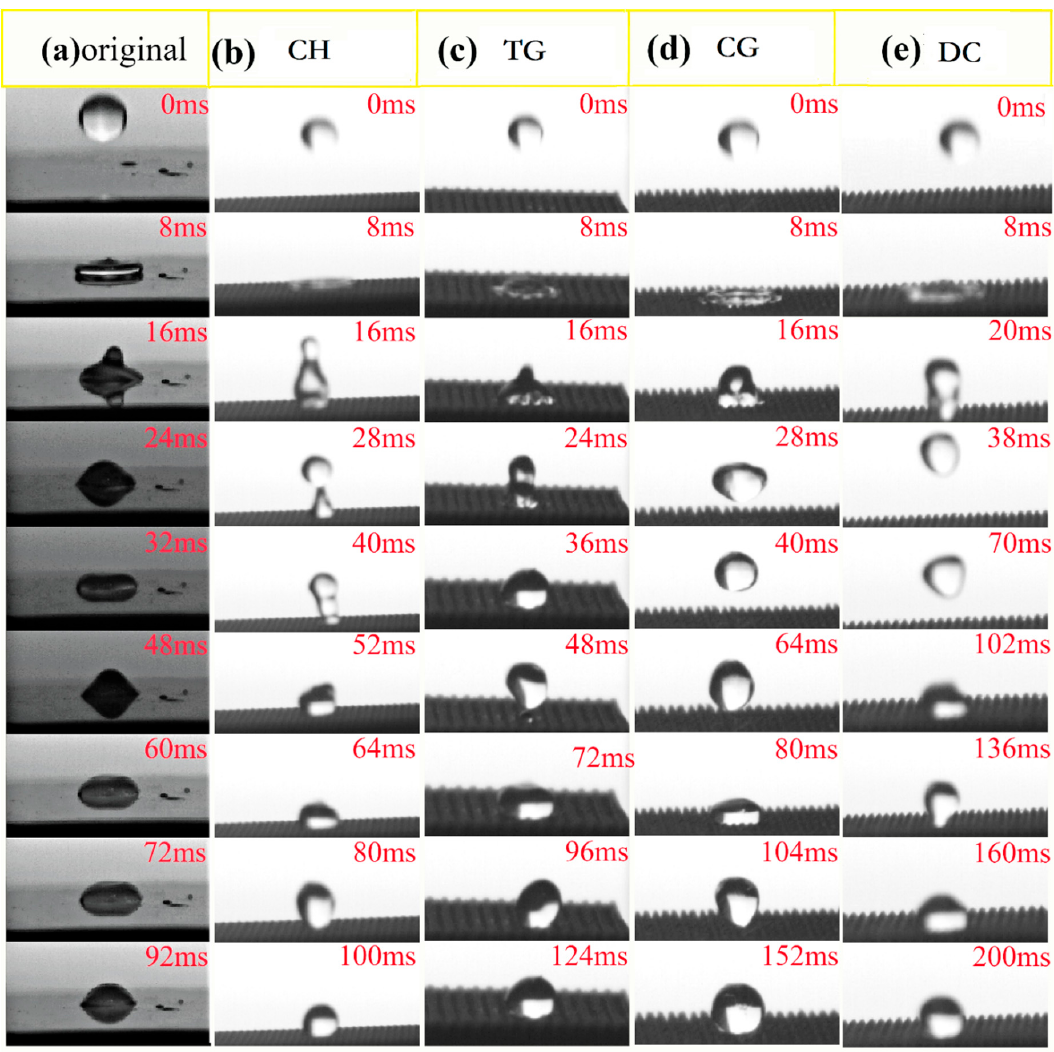
Figure 11. ( a ) Rolling time and ( b ) rolling speed of the droplet dripping on the different textured surfaces against inclination angle and instantaneous snapshots of a droplet dropping onto ( c ) original sample and ( d ) diamond column textured sample.